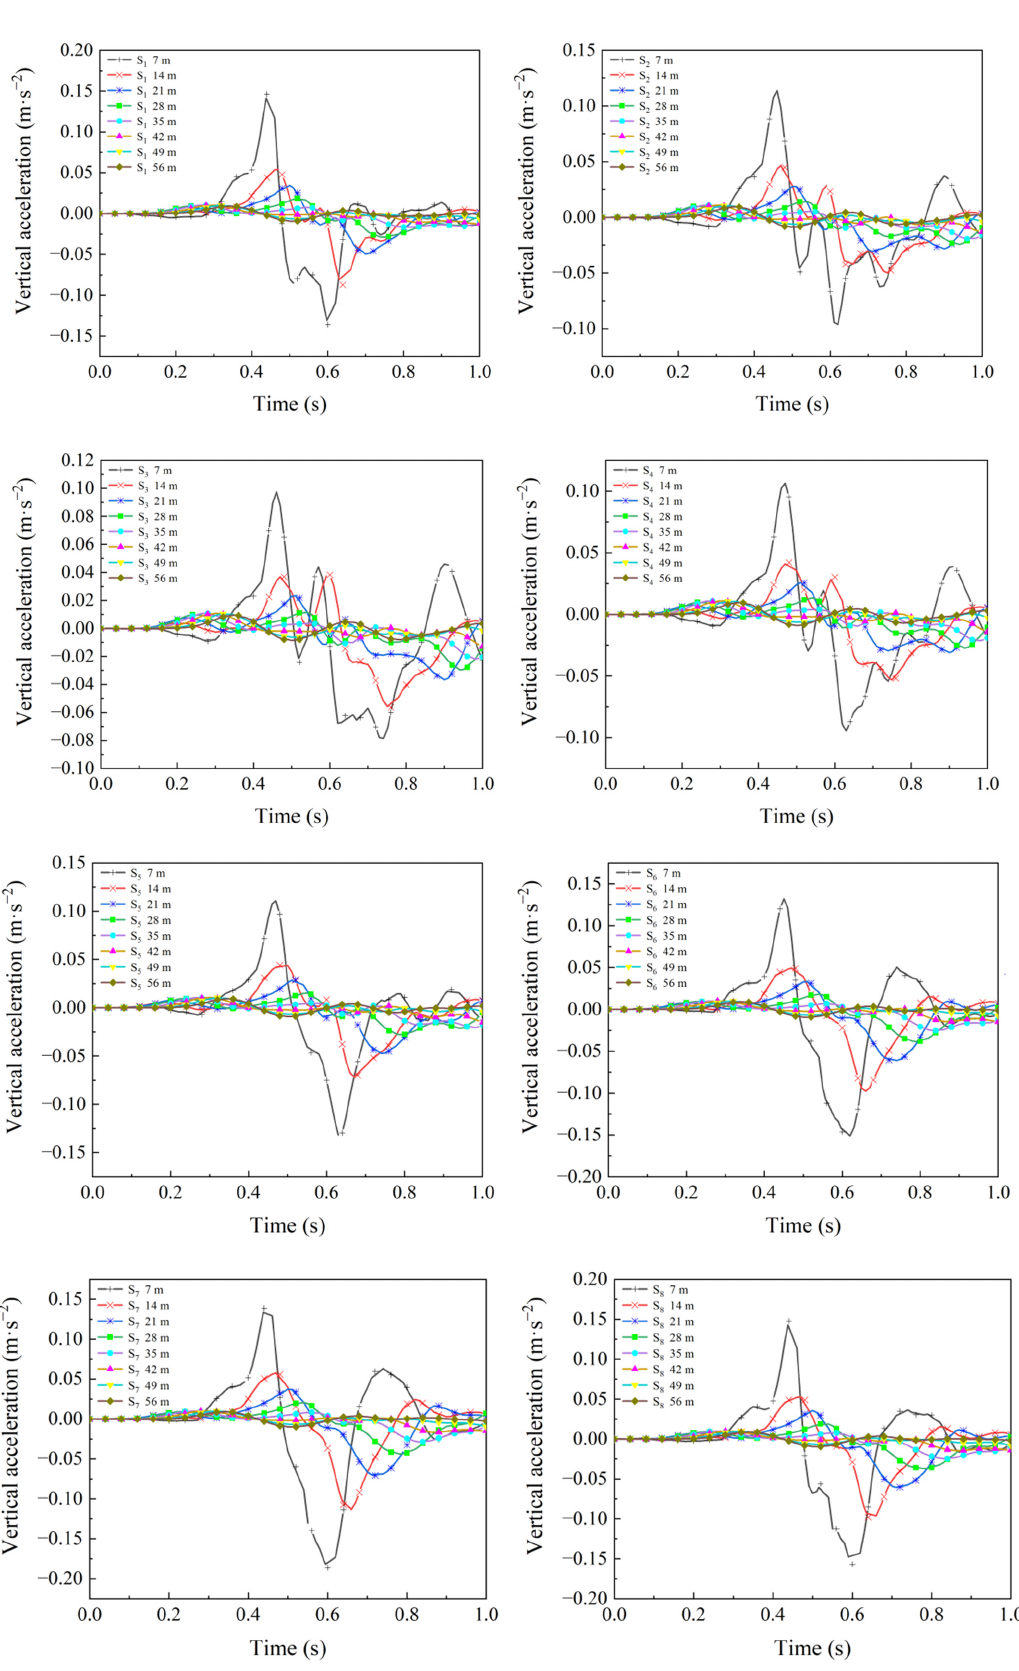
Figure 13. Vertical acceleration-time curves of monitoring points under different burial depths.